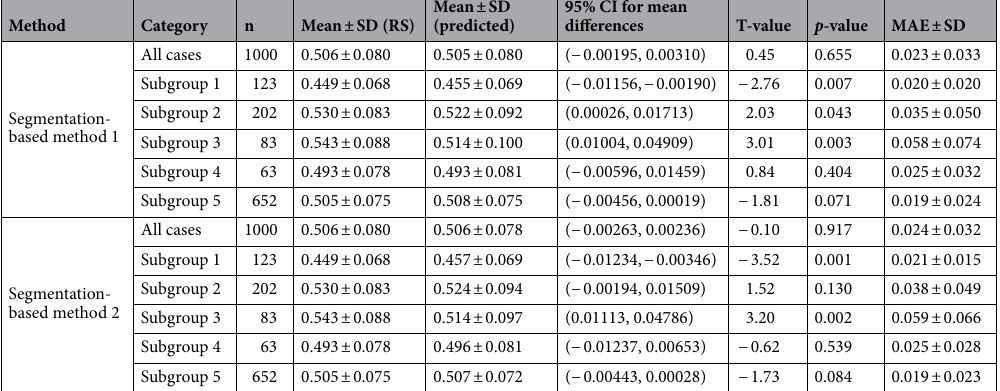
The overall mean absolute errors (MAEs) of methods 1 and 2 for the entire test dataset were 0.023 and 0.024, respectively. Similar to the diagnostic performance, the largest MAE for each method occurred in subgroup 3 (MAE ± SD, method 1: 0.058 ± 0.074; method 2: 0.059 ± 0.066). For subgroup 5, in which hard cases were excluded, the corresponding MAEs were the smallest in each method (MAE ± SD, method 1: 0.019 ± 0.024;